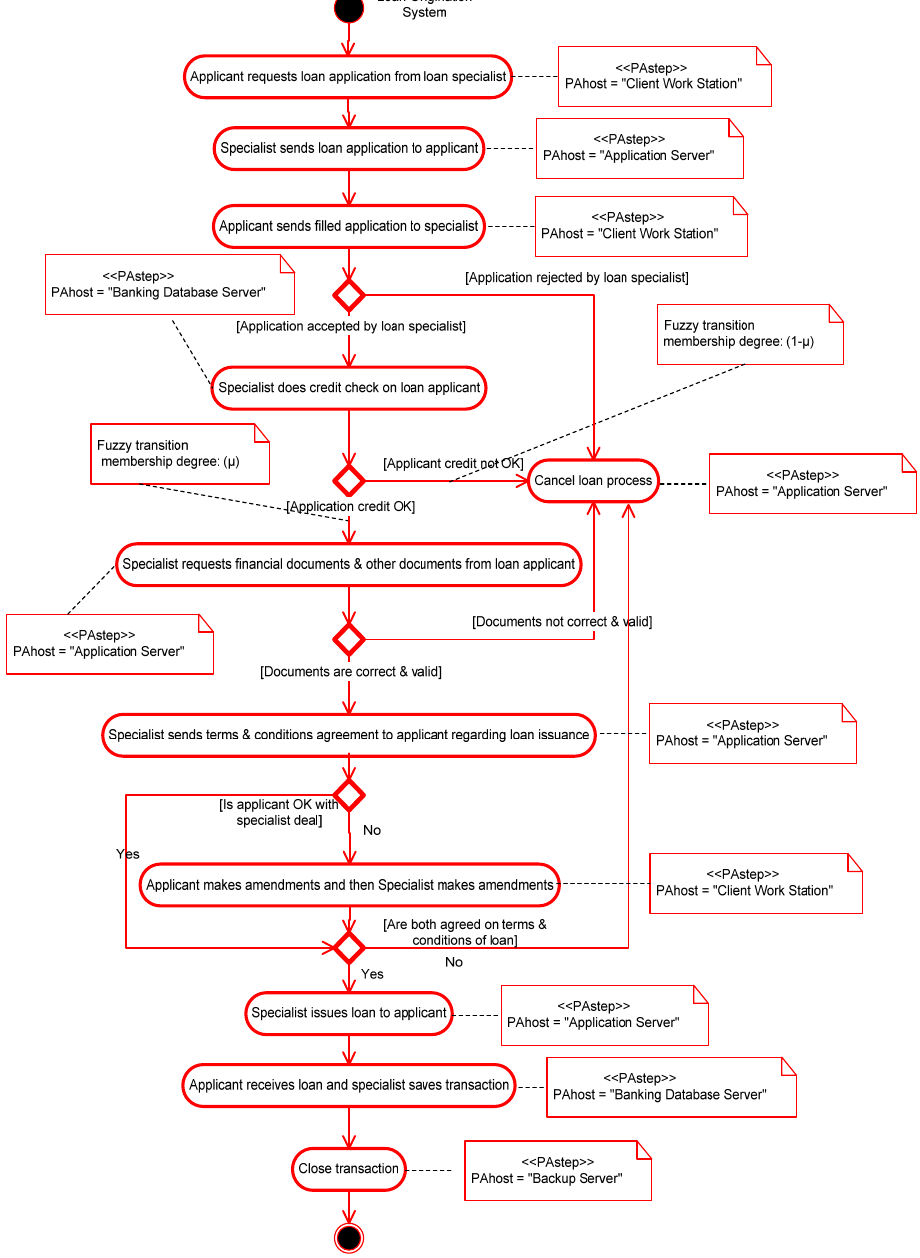
Fig. 4. Activity diagram with performance